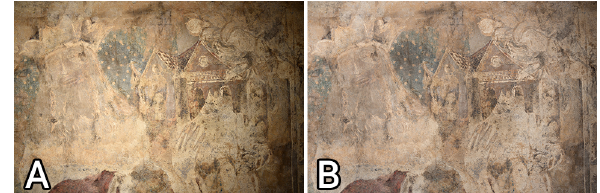
Figure 2 . The original photographs' orange tint and illumination gradient (A) are removed in the final images (B).